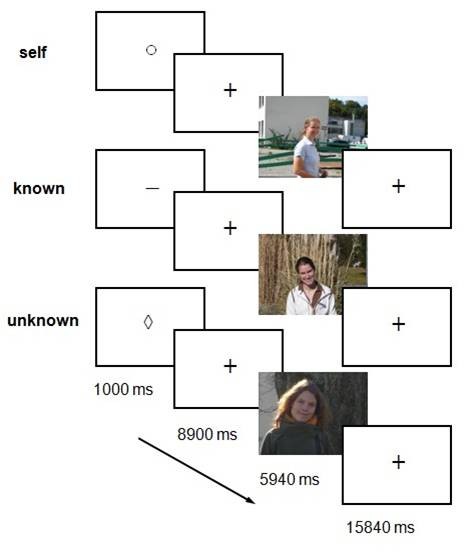
Brain activity during reflection on oneself. Analysis of selected regions (yellow circles) with activation during reflecting on oneself, resulting from the conjoined contrast (refl-self > refl-known) & (refl-self > refl-unknown) & (refl-self > perc-self) – (2). The colour-coded maps indicate those areas of the brain with greater t activity during self-reflection than under all other conditions (p < 0.005, Monte Carlo simulation with cluster wise correction p < 0.01). The time courses indicate the mean and standard errors of blood oxygen-level-dependent signal changes under primary conditions. (A) DMPFC. (B) Ventrolateral prefrontal cortex and insula (VLPFC/Ins. L). (C) DLPFC R. (D) Posterior cingulate cortex (PCC). All regions have greater activity during the reflection periods than during perception of the photograph. All other significant clusters were also activated under the ‘other’-reflection-conditions.